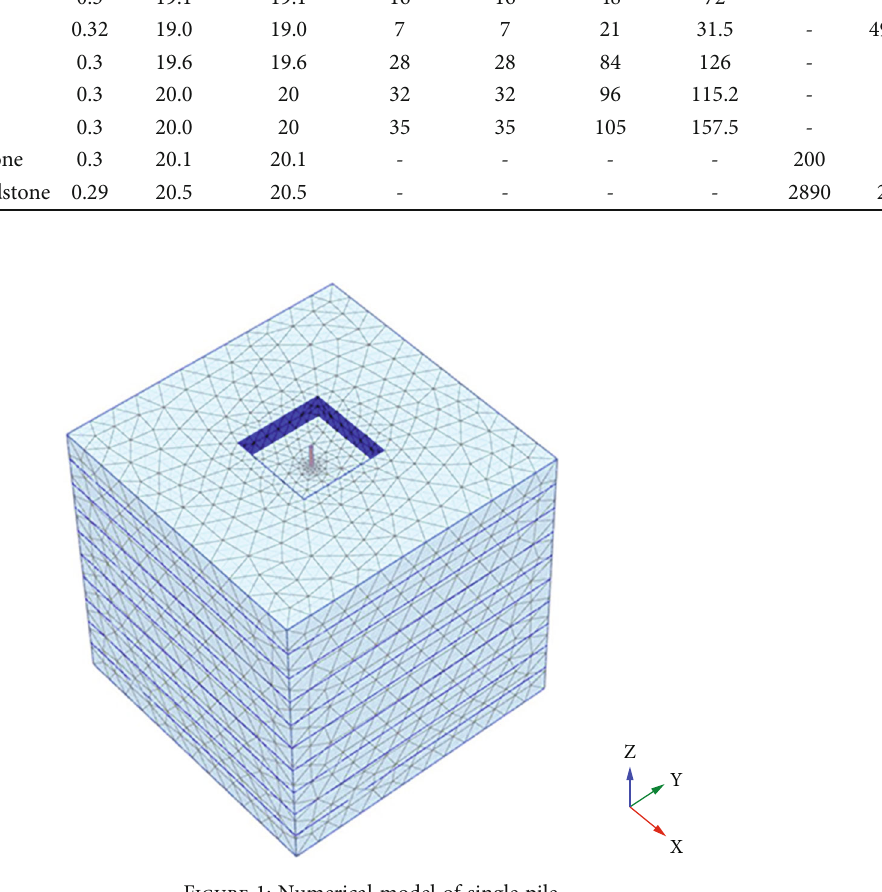
Figure 1: Numerical model of single